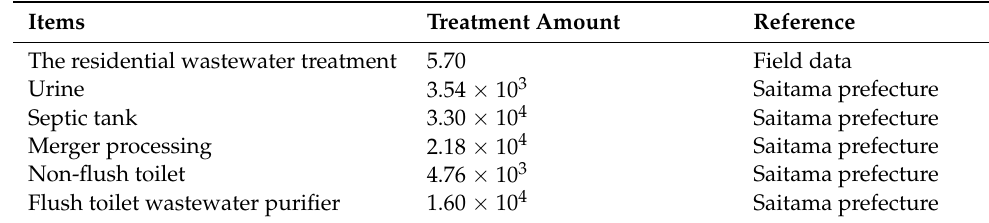
Table 6. Activity data of treatment amount and reference.